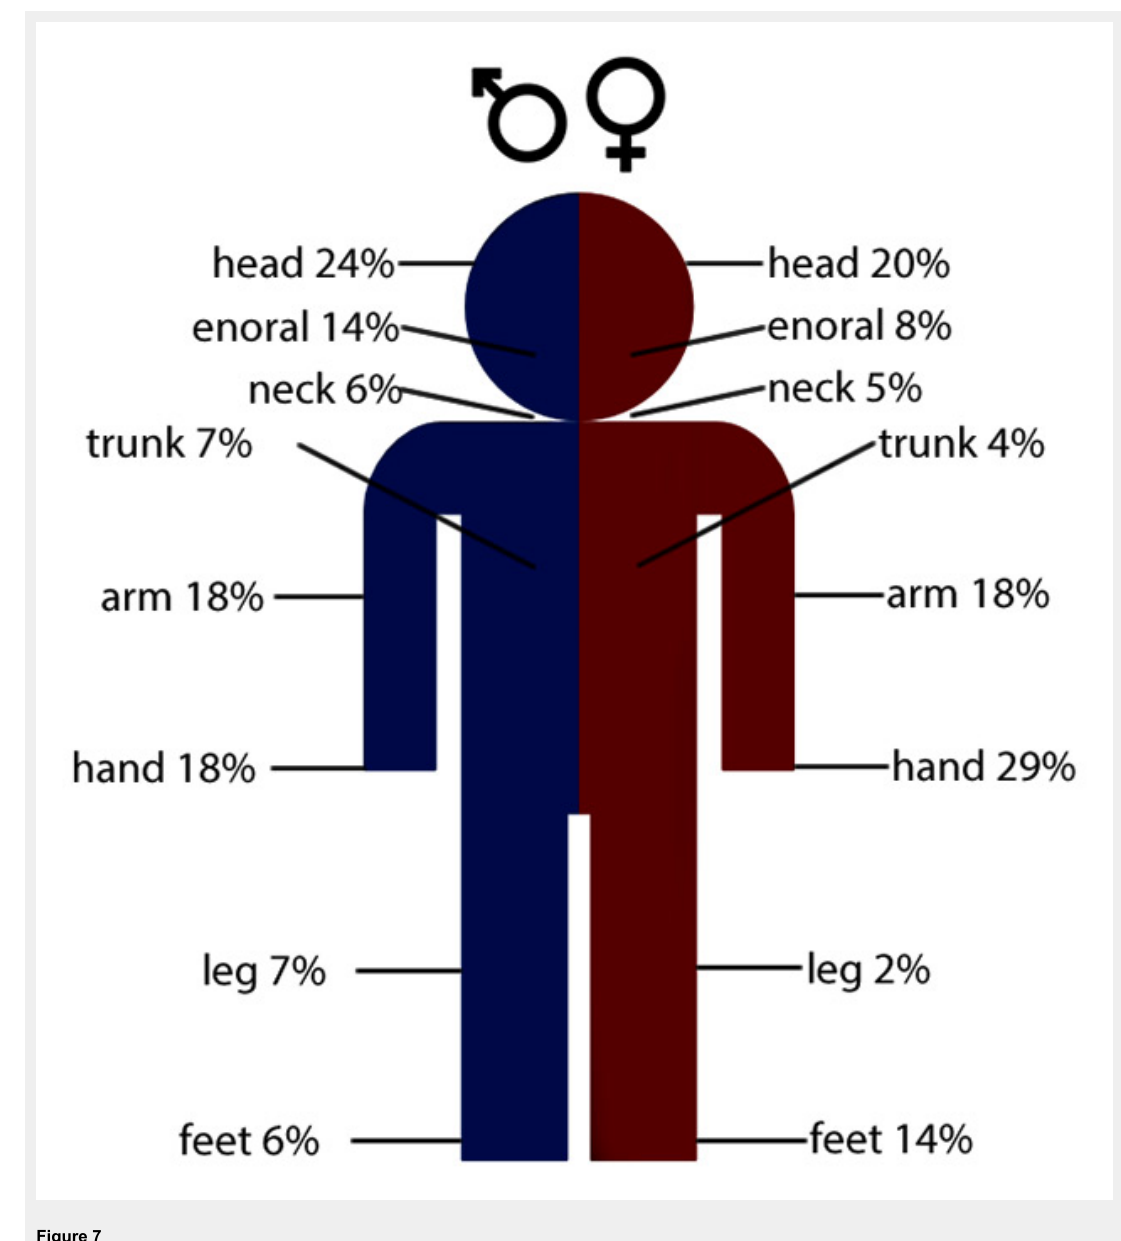
Figure 7 Localisation of recorded stings for each body region in men (blue) and women